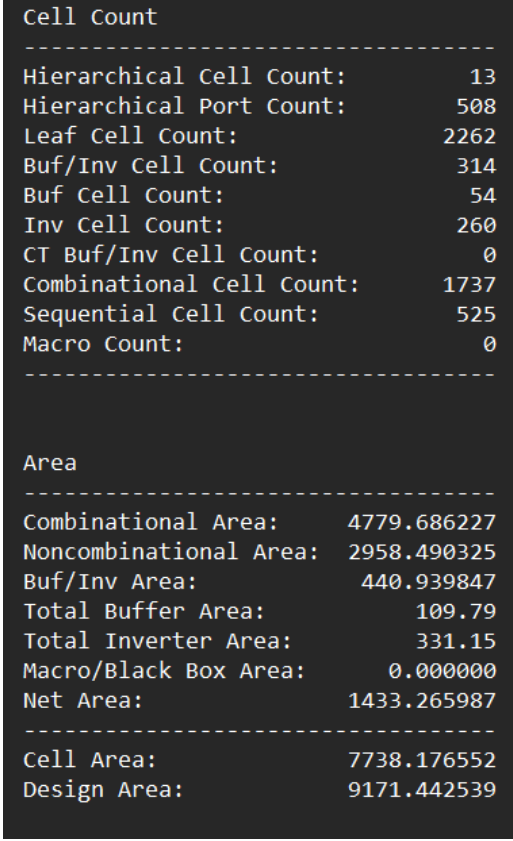
Figure 22. Log data